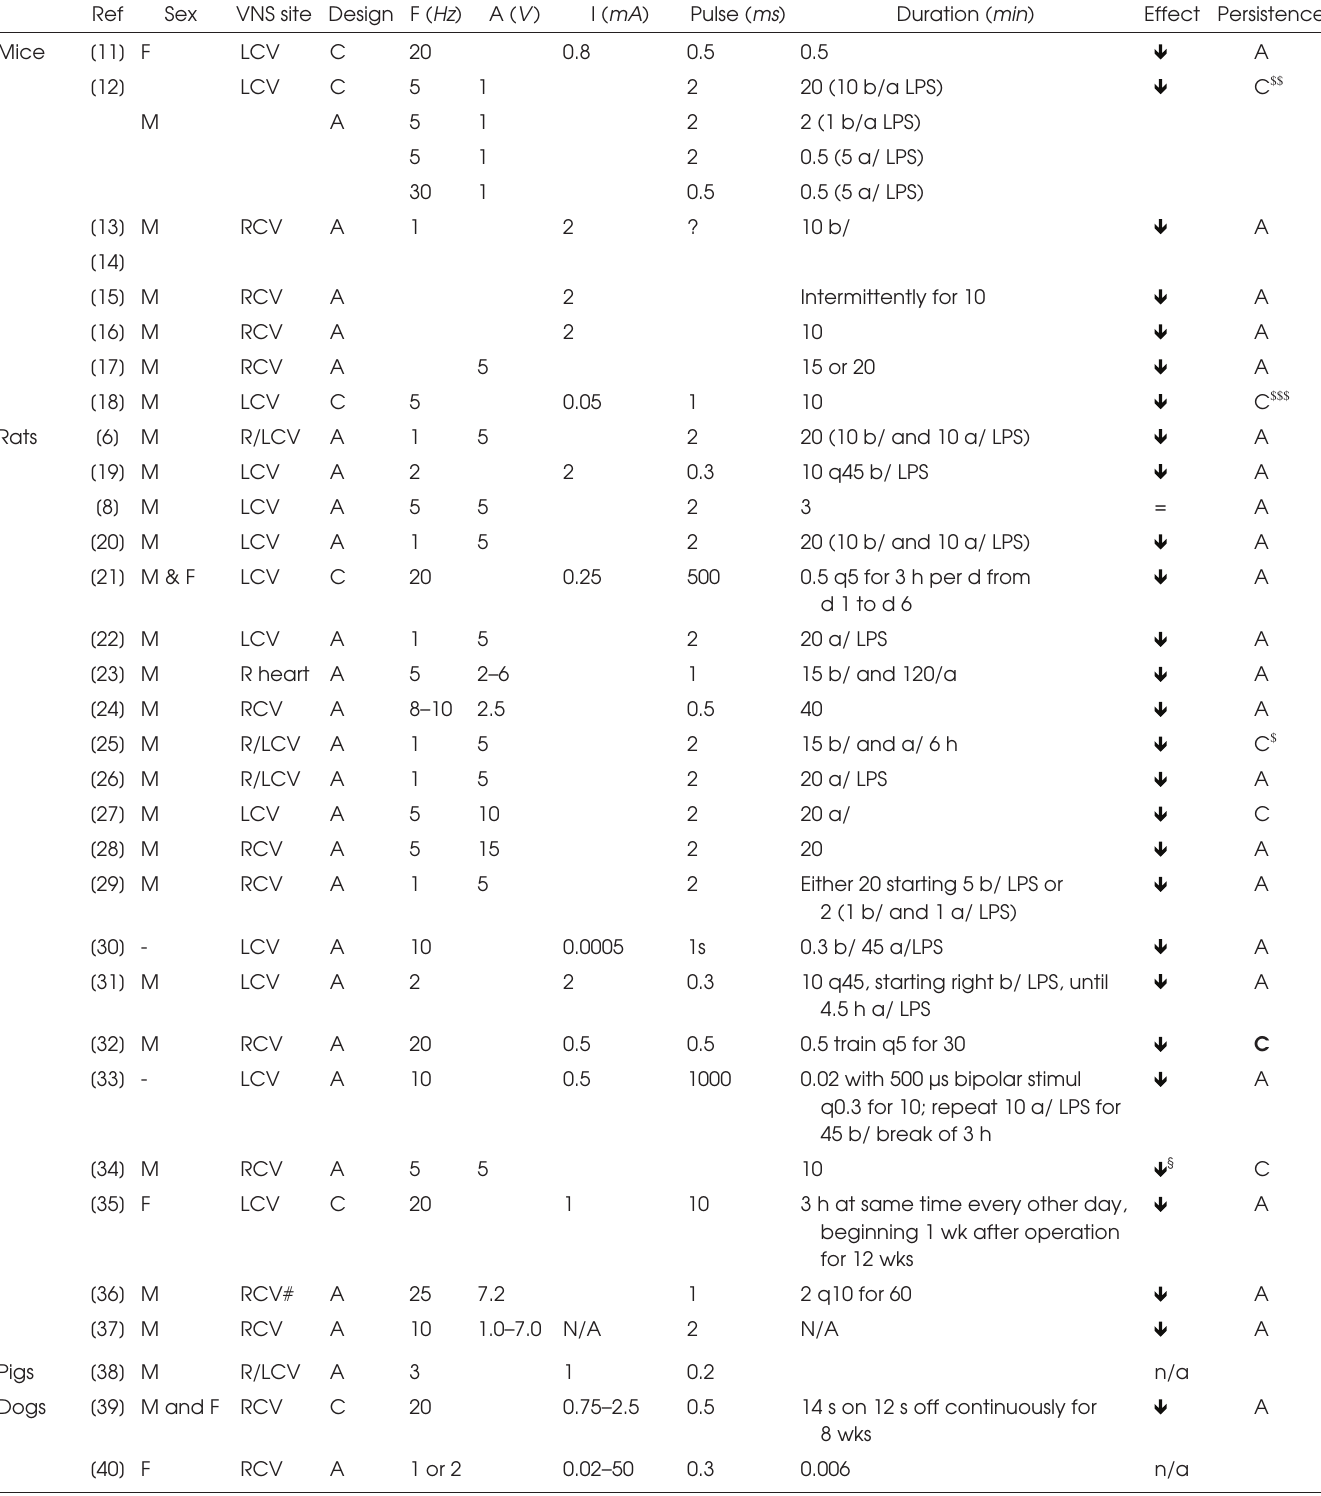
Table 1. Summary of the systematic literature review on antiinflammatory effects of VNS treatment in animal models and human trials.